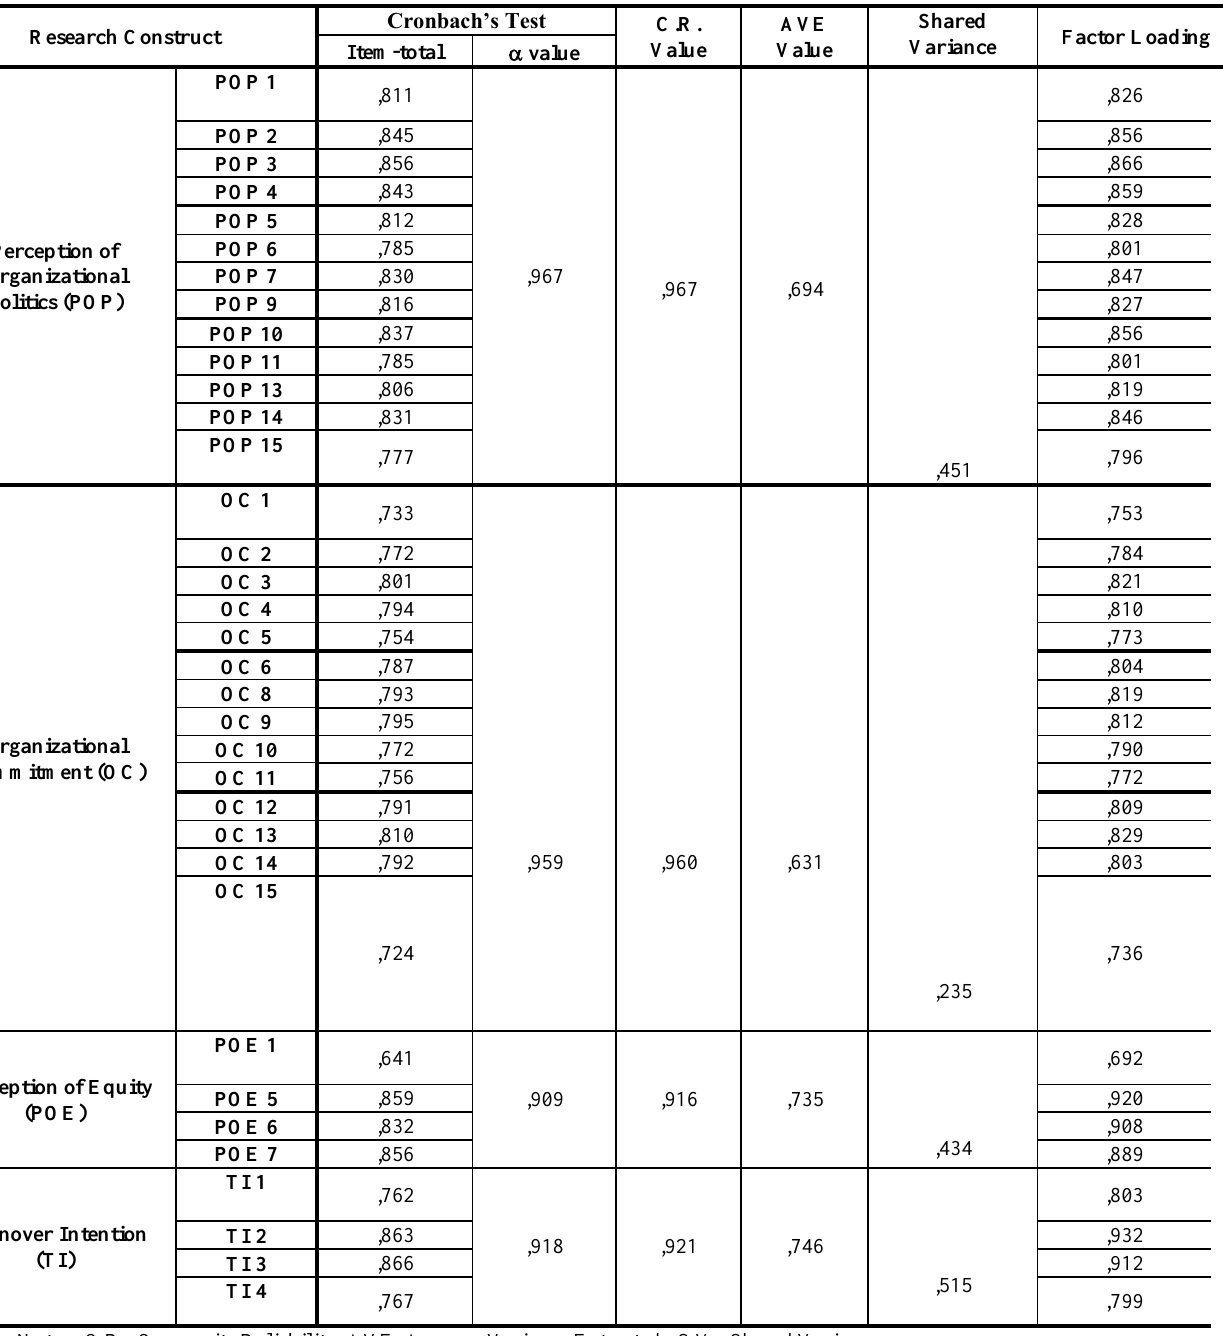
Table 2: Accuracy analysis statistics Research